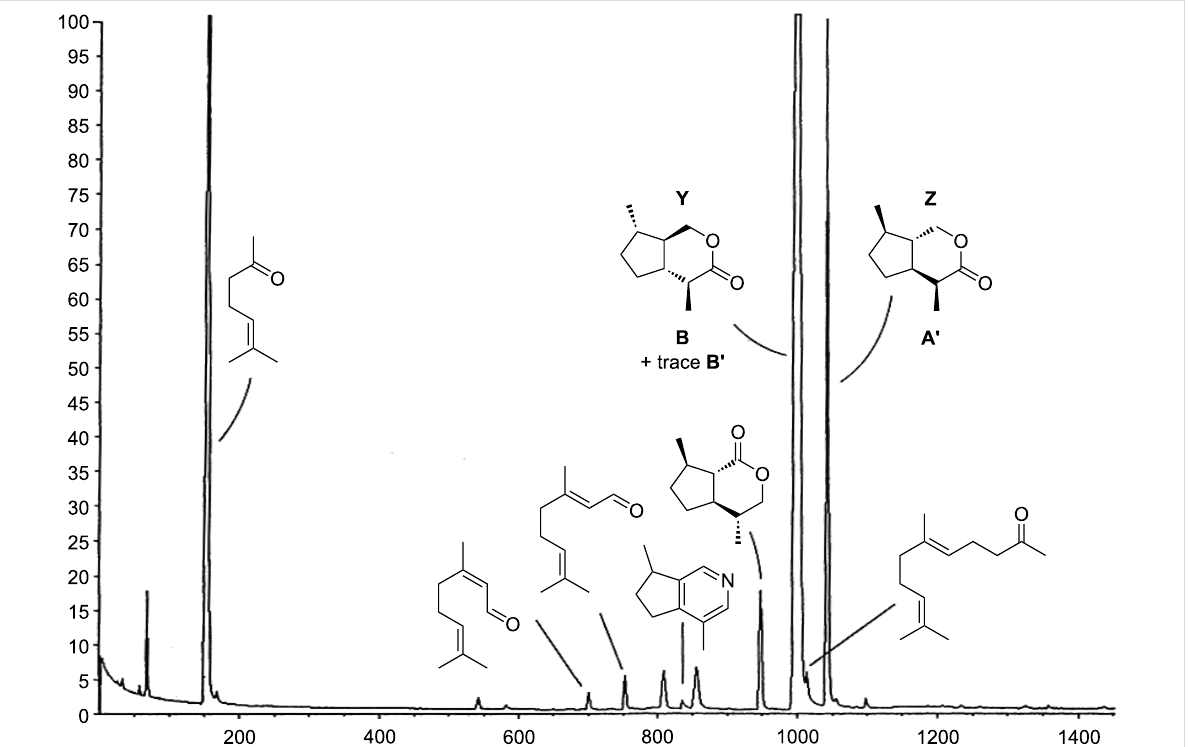
Figure 7: Volatile terpenoids in the cephalic secretion of Alloxysta victrix . For the identification of compounds other than Y and Z see [1].